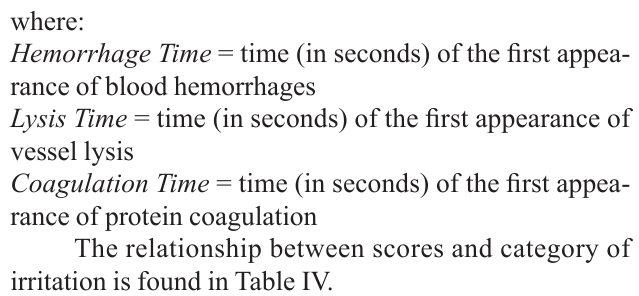
Table adapted from CAMVA, 2008.